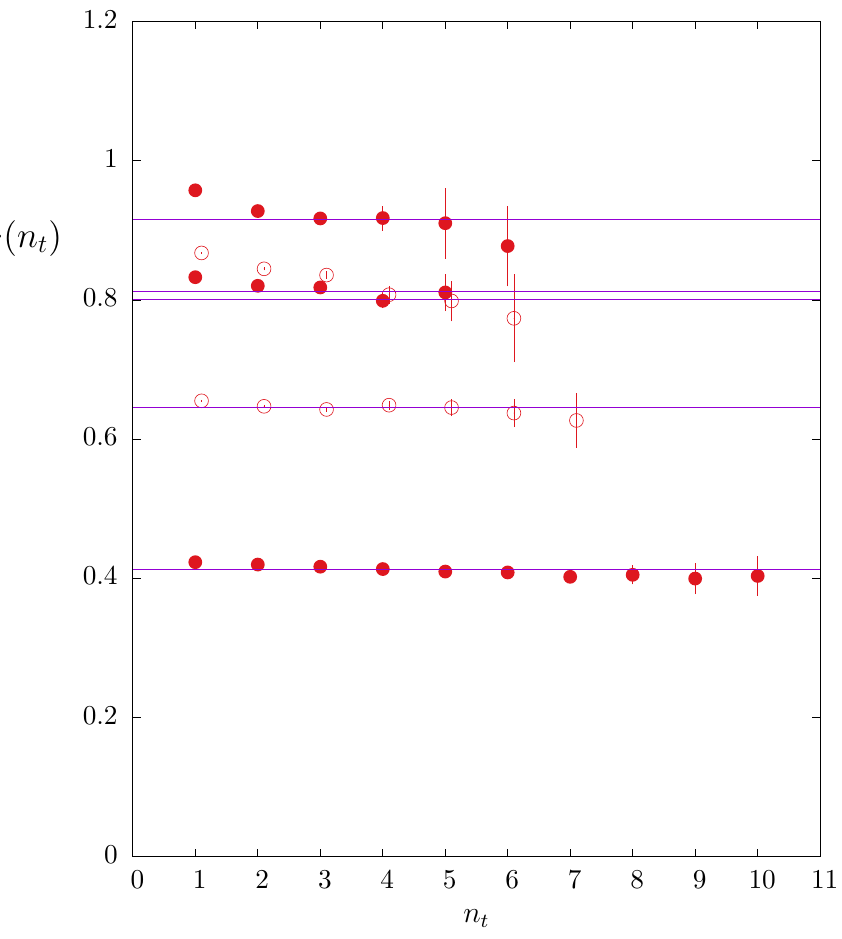
Figure 2 . E(cid:11)ective masses of the lightest (cid:12)ve J P = 0 + glueballs in SO(12) at (cid:12) = 250. Lines are mass